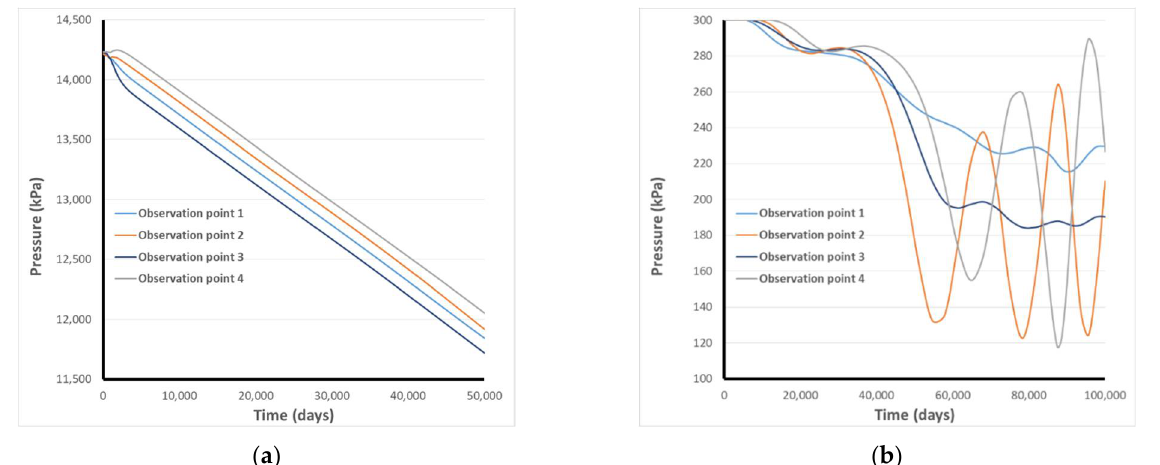
Figure 4. Pressure and temperature decay at the observation points in the long term: ( a ) pressure decay indicating pseudo-steady-state; ( b ) temperature decay leads to instability.